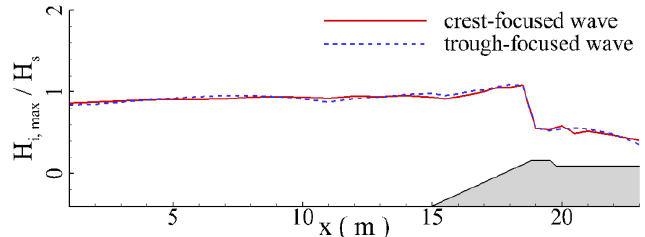
Figure 12. Space distribution of the local maximum local wave